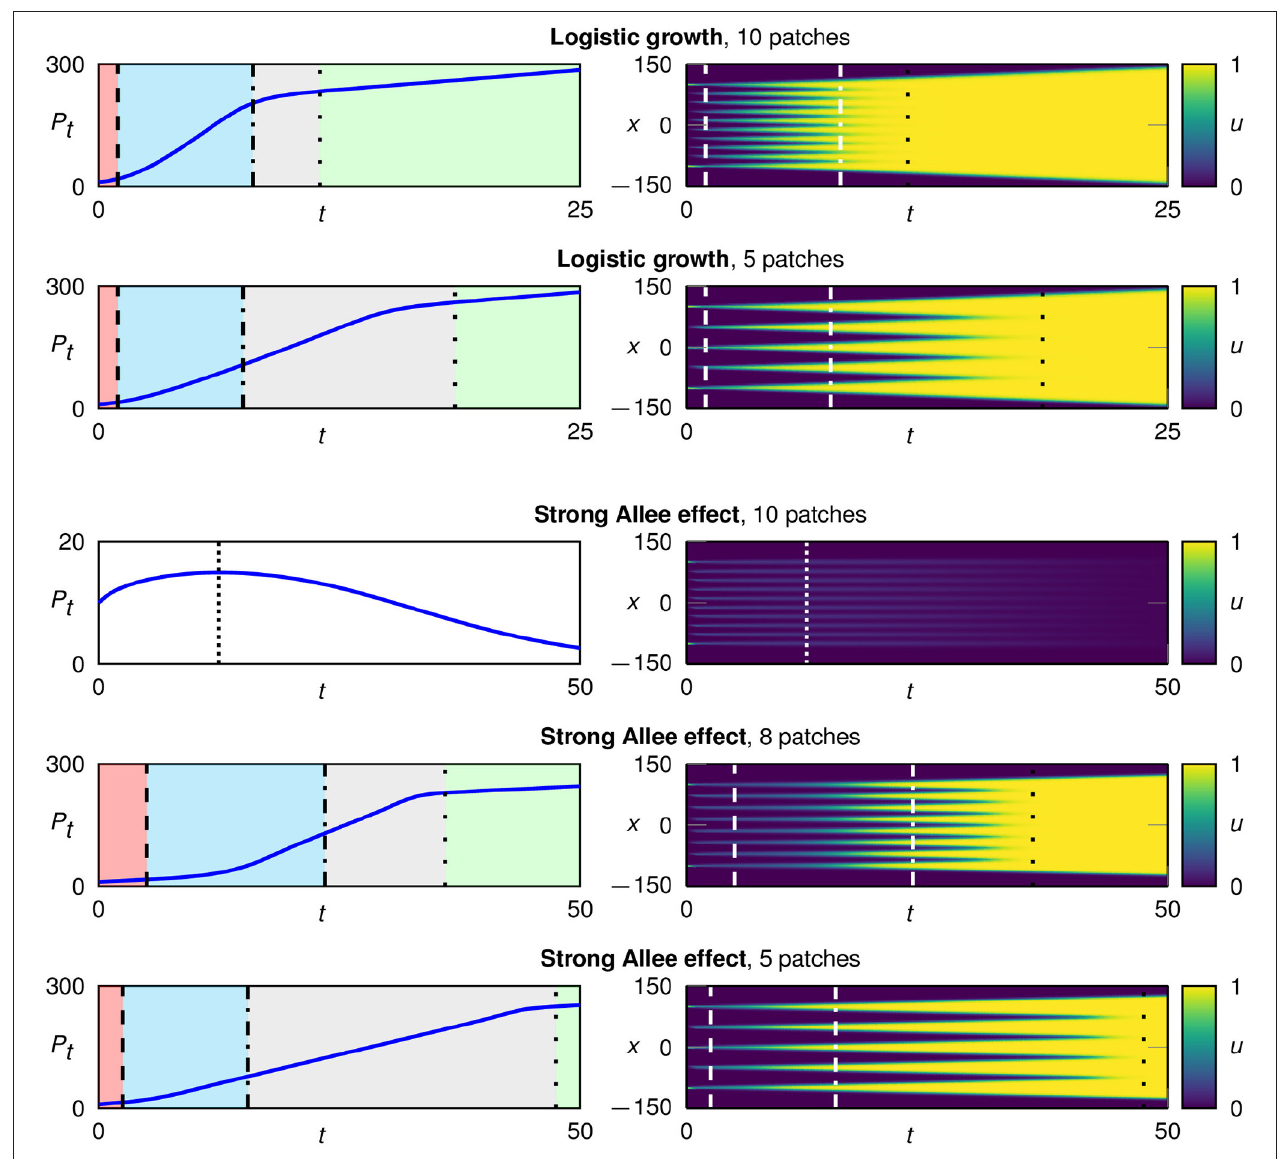
FIGURE 4 | Typical development in configurations starting with multiple initial patches for logistic growth f L ( u ) (rows 1 and 2) and the strong Allee effect f A ( u ) with a 0.1 (rows 3–5) . We plot the total population size over time (left) and the spatio-temporal development in color coding (right) . In the case of logistic growth, the = population survives for all spatial configurations. In contrast, for a strong Allee effect, populations starting from a configuration with many and therefore very narrow patches go extinct. A surviving population undergoes four characteristic growth phases: 1. flattening of each patch (red), 2. regrowth of each patch (blue), 3. traveling fronts for each patch (gray), and 4. expansion of the merged patch